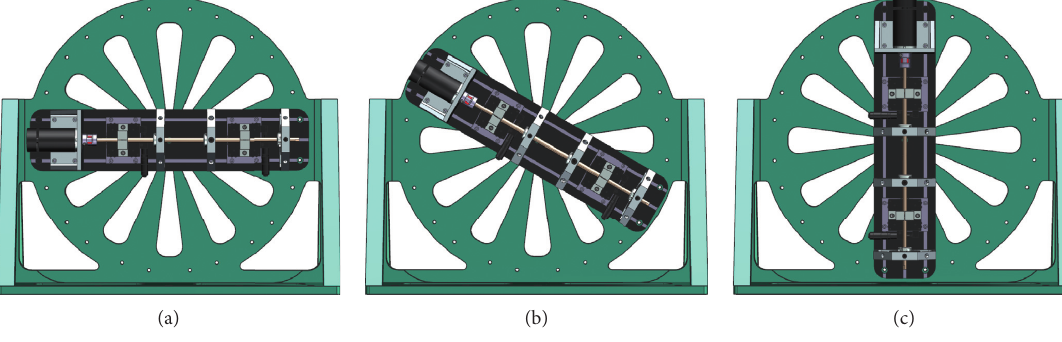
Figure 4: Diagrams of pitch angle. (a) 0 ° . (b) 30 ° . (c) 90 ° .